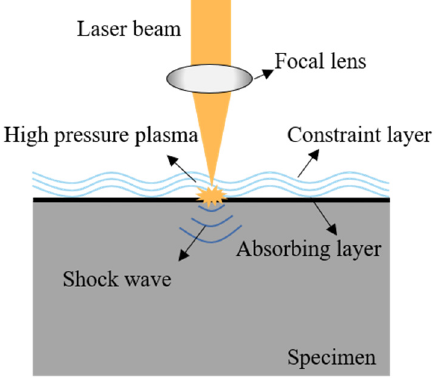
Figure 1. Schematic diagram of laser shock peening (LSP).